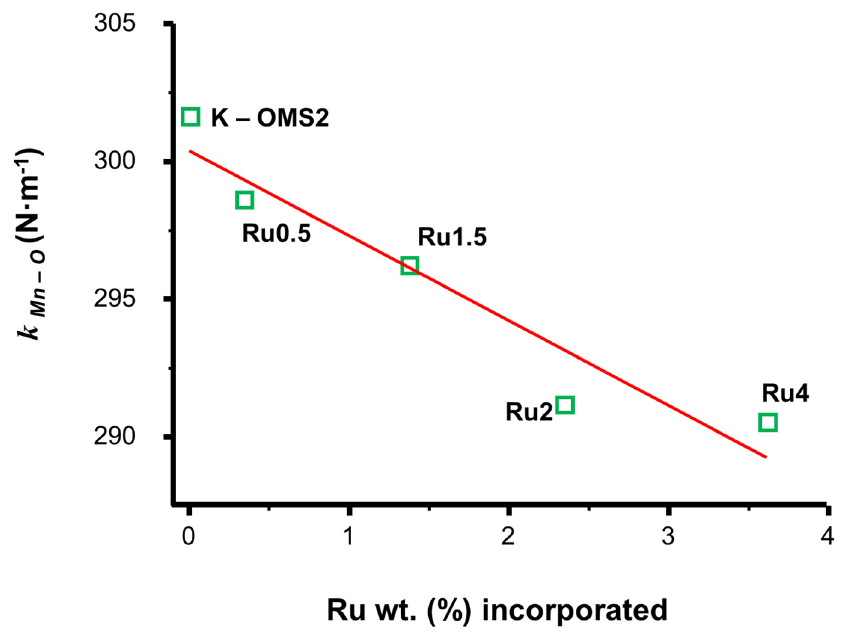
Figure 11. Graphic representation of the Mn-O strength (N · m − 1 ) versus the amount of ruthenium incorporated in the structure: Ru0.5 (0.5% wt.), Ru1.5 (1.5% wt.), Ru2 (2.0% wt.) and Ru4 (4.0% wt.). Extracted from [133].